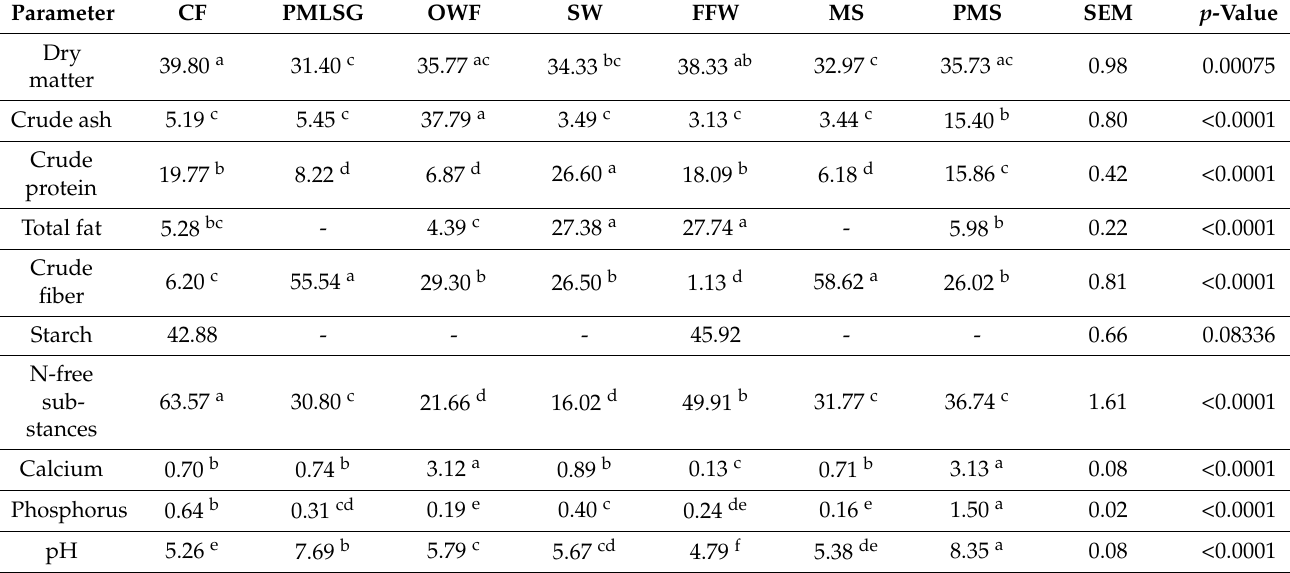
Table 2. Chemical composition and pH of the substrates 1 (dry matter expressed in %, all macronutri- ents expressed in % of dry